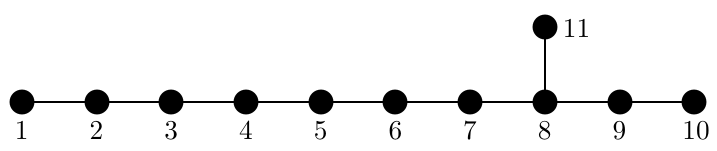
Figure 1 . Dynkin diagram of E 11 with labelling of nodes used in the